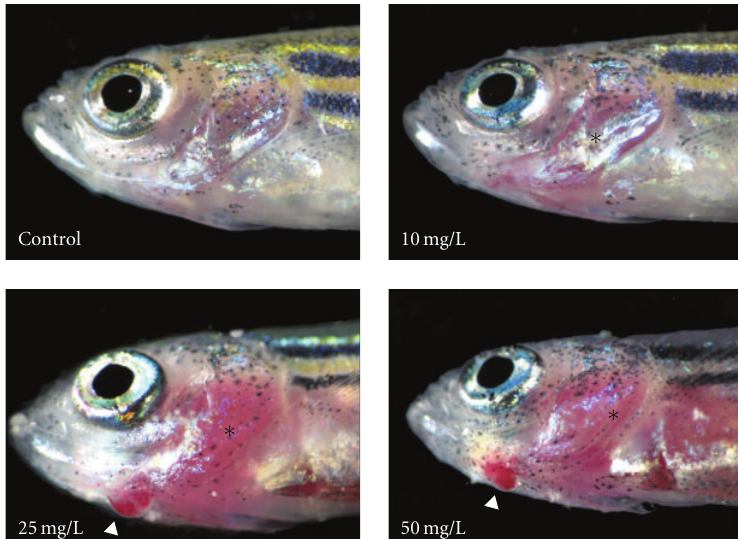
Figure 4: Representative macroscopical pictures of the head region of zebrafish ( Danio rerio ) following exposure to 0, 10, 25, and 50 mg/L PTU. Increased red coloration due to blood aggregation in the opercular region ( ∗ ) at concentrations ≥ 10 mg/L and goiter formation ( (cid:6) ) at concentrations ≥ 25 mg/L are clearly detectable.